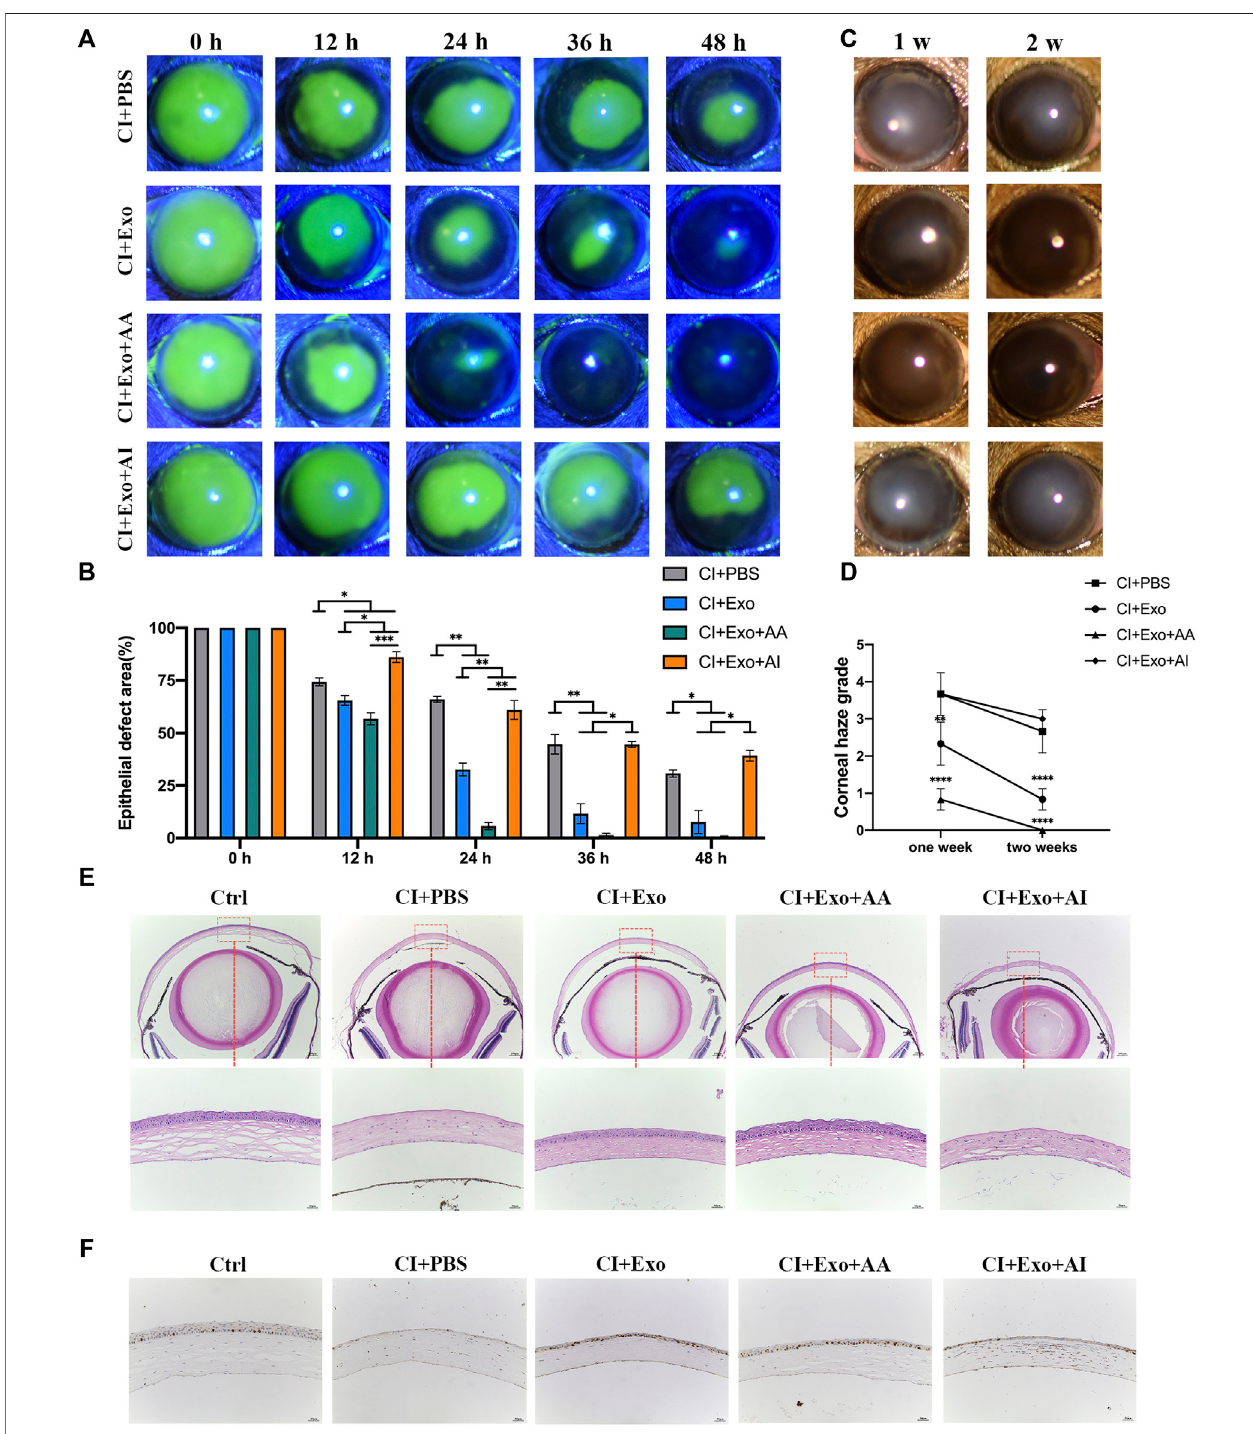
FIGURE 6 | Effect of combination treatment with hucMSC-Exos and autophagy regulators on corneal clinical and pathological examination. (A,B) Corneal fl uorescein staining showing the representative images of the corneal epithelial defect areas. Data are quanti fi ed in the bar graph. (C,D) Slit lamp showed the representative images of corneal haze. Haze-grading data were quanti fi ed using a line chart. (E) Mouse eyeballs were harvested at 48 h post-injury. HE staining for the histological structure of cornea wound healing. Scale bar: 250 and 50 μ m. (F) Mouse eyeballs were harvested at 48 h post-injury. Immunohistochemical staining showingexpressionoftheproliferationmarkerKi-67.Dataareshownasmean±SD.*p < 0.05,**p < 0.01,***p < 0.001,****p < 0.0001.(Control:normalcorneastreated with PBS, CI + PBS: injured corneas treated with PBS, CI + Exo: injured corneas treated with 1 × 10 6 / μ l hucMSC-Exos, CI + Exo + AA: injured corneas treated with 1 × 10 6 / μ l hucMSC-Exos and 10 μ M Rapamycin, CI + Exo + AI: injured corneas treated with 1 × 10 6 / μ l hucMSC-Exos and 50 μ M Compound C).